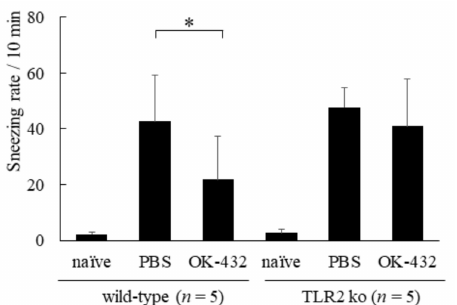
Figure 10. Sneezing rate in a murine model of wild-type and TLR2 knock-out mice systemically sensitized with OVA and receiving subsequent intranasal challenge of OVA. Naive mice underwent no systemic sensitization. PBS-treated mice were i.p. injected with PBS on day 0 and day 7. OK-432-treated mice were i.p. injected with 100 mg OK-432 on day 0 and day 7. Data were obtained and expressed as